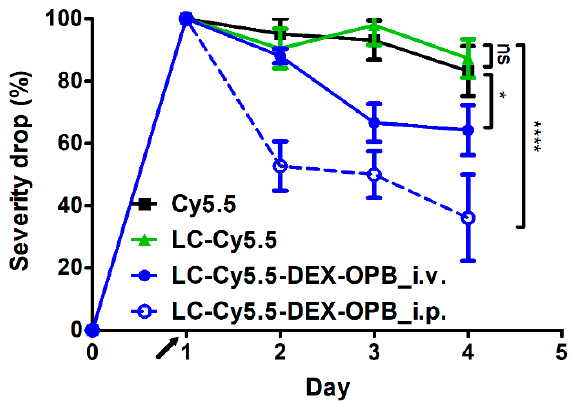
Figure 5. Decrease in the clinical severity (CS) of the inflammation in the mouse ankle in the experiment of biodistribution. Injection of the 0.1 mg Cy5.5 eq/kg and 0.6 mg DEX-OPB/kg, n = 6.